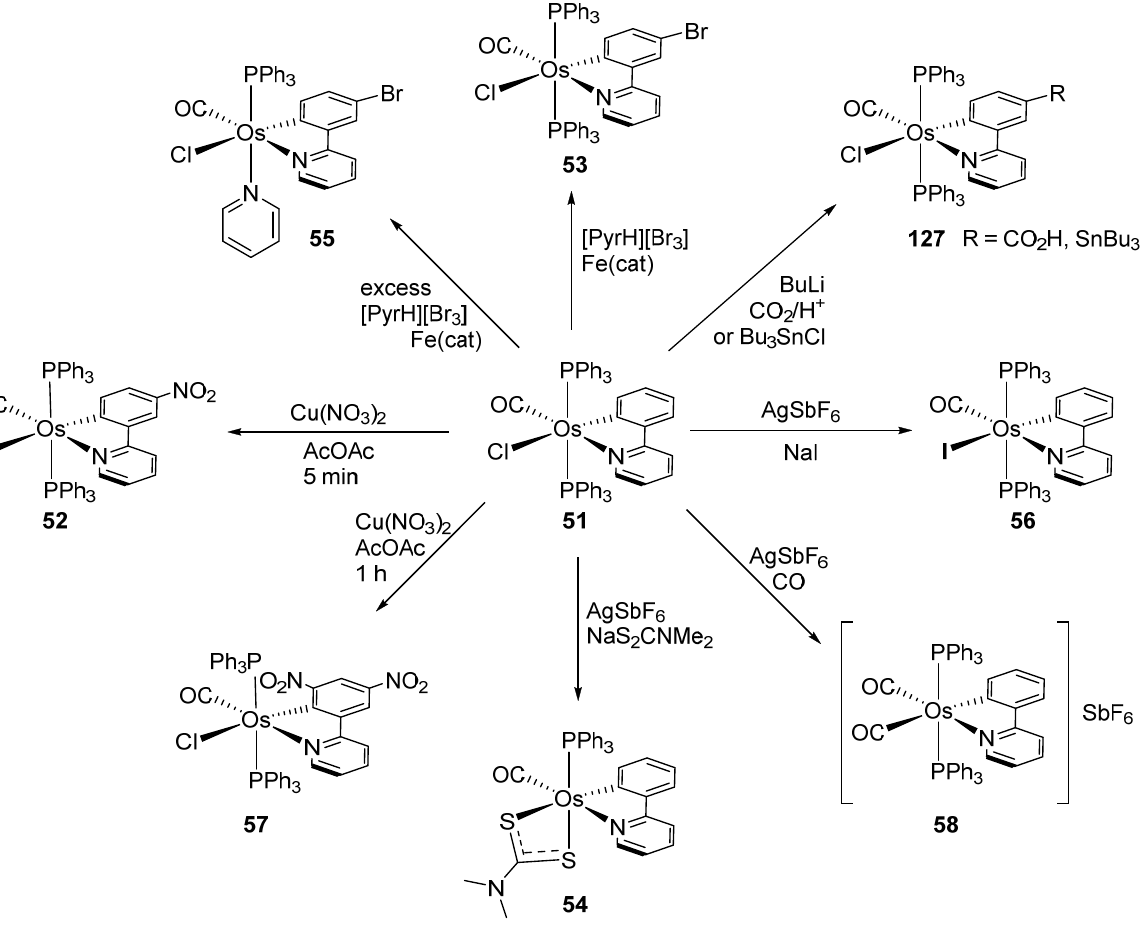
Figure 28. Electrophilic substitution reactions at the phenyl ring of cyclometalated complex 51 .